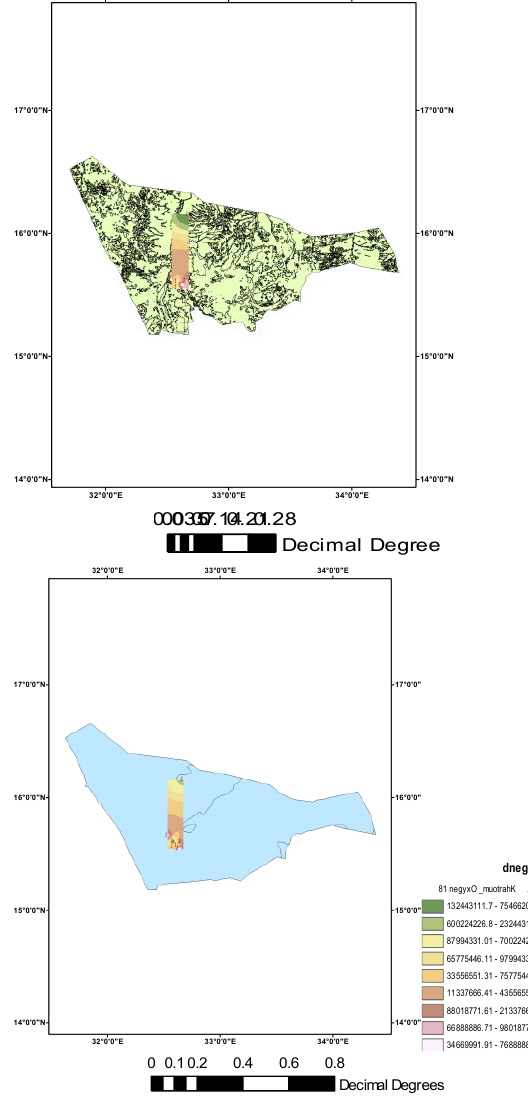
Fig 11. Khartoum -hydro geological -Oxygen